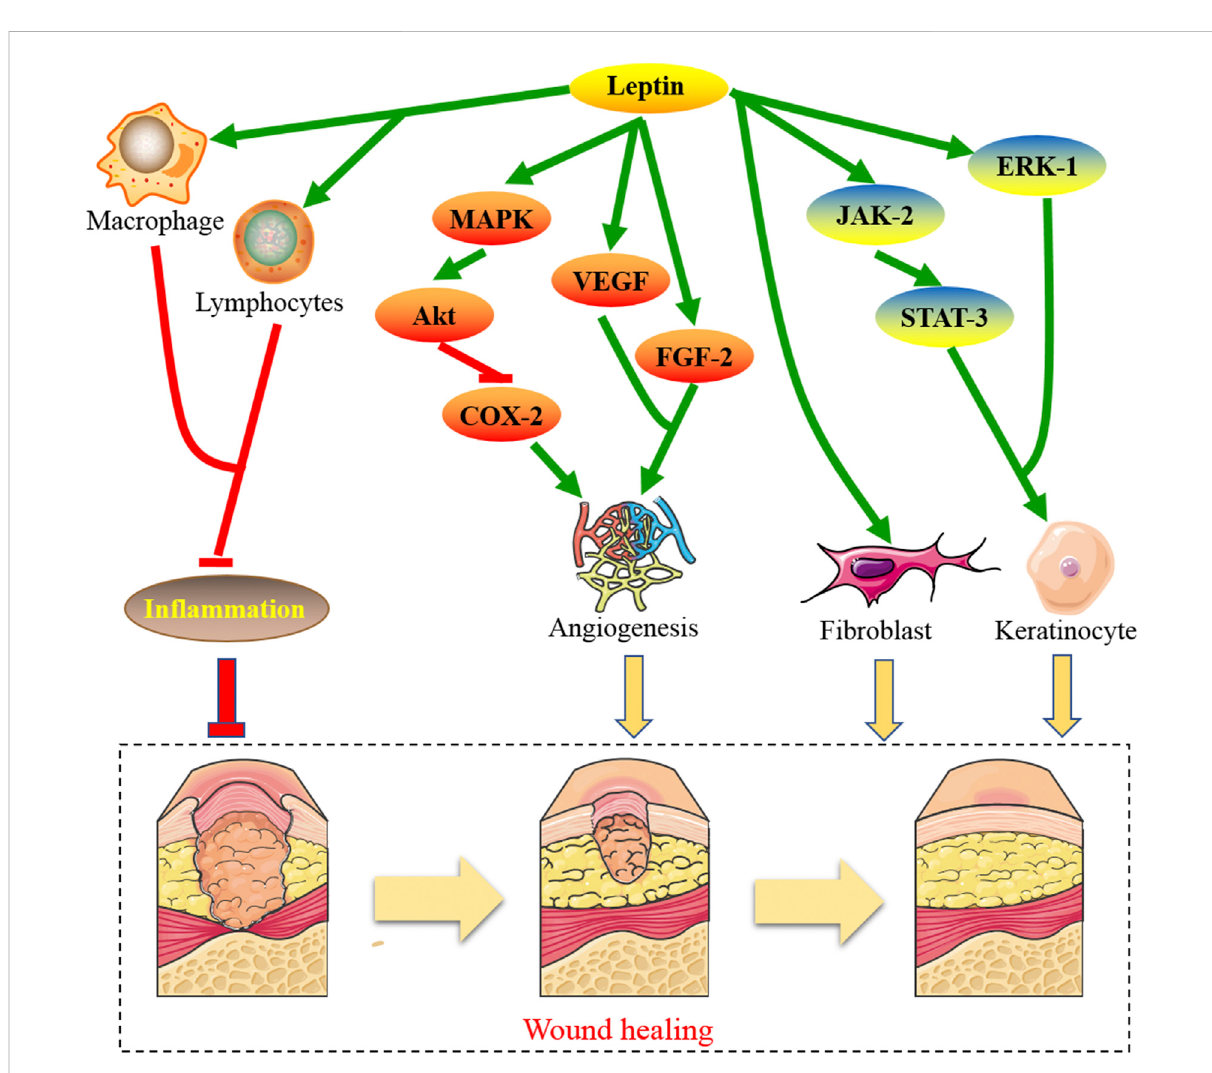
FIGURE 1 The molecular mechanisms by which leptin contributes to the treatment of wound